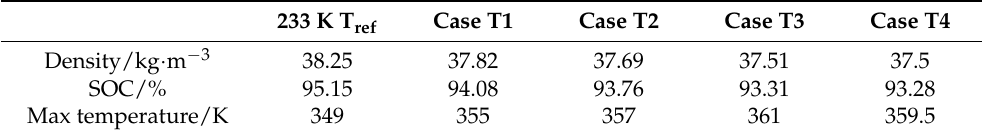
Figure 19. Evolutions of the hydrogen temperature rise of Cylinder B at different pre-cooling patterns. Table 5. Hydrogen density, SOC, and maximum temperature under different pre-cooling pa tt erns.